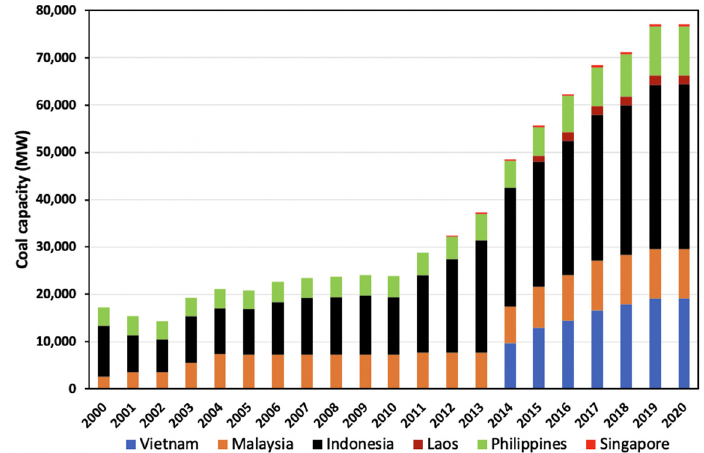
Figure 13. History of installed coal-power capacity in ASEAN [22] .